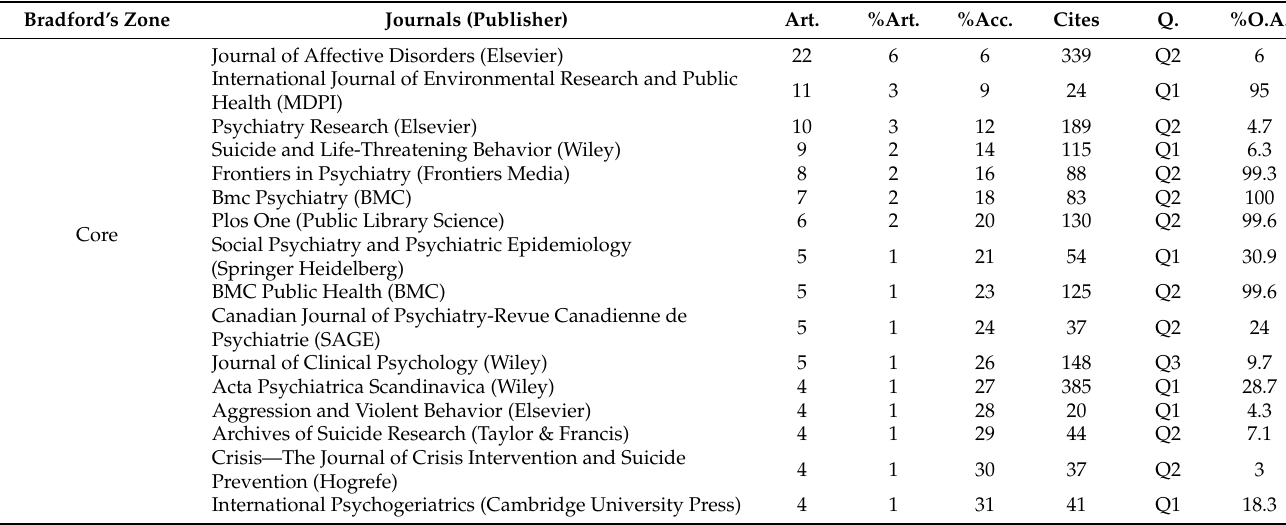
Table 2. Bradford Core Journals.